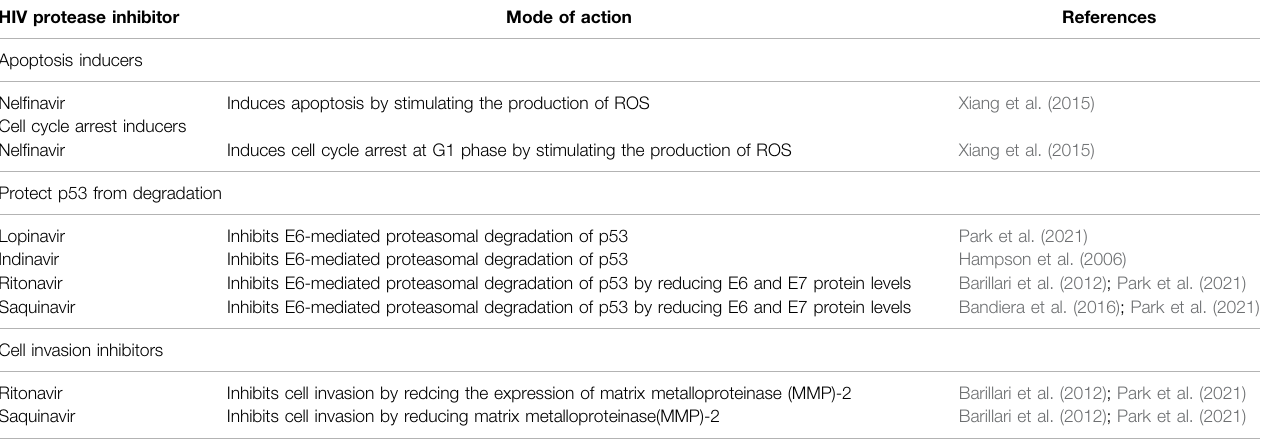
TABLE 2 | The mechanisms of different HIV protease inhibitors in cervical